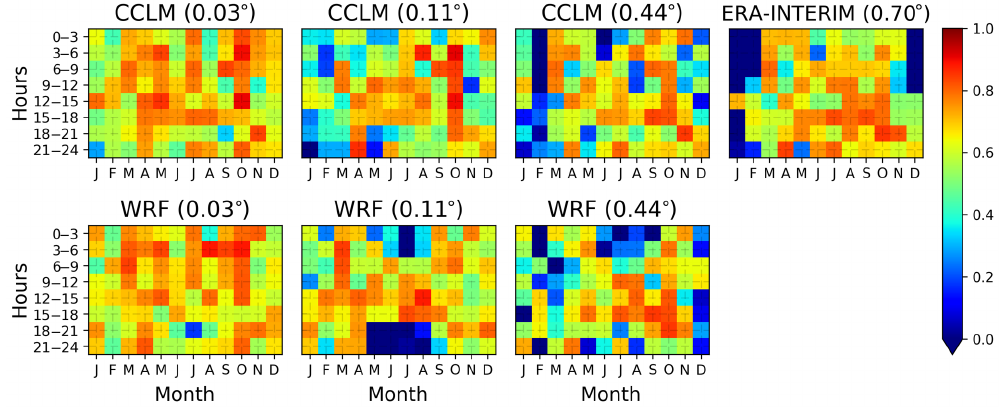
Figure 4. Added value of using higher model resolution. The colour bar corresponds to the correlation coefficients between the observed and the modelled spatial fields of averaged precipitation. The x axes and the y axes show the months of the year and the hours of the day,